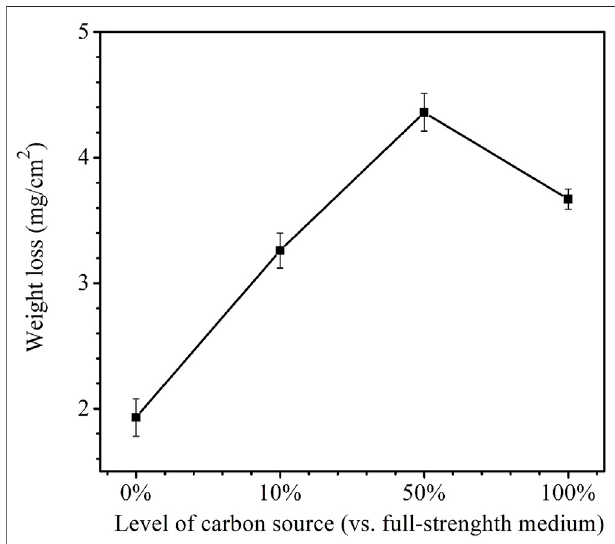
FIGURE 2 | Weight losses after 14-day starvation incubation in 450-ml anaerobic bottles with varied carbon source levels. (Each error bar represents a range of readings from three coupons in the same anaerobic